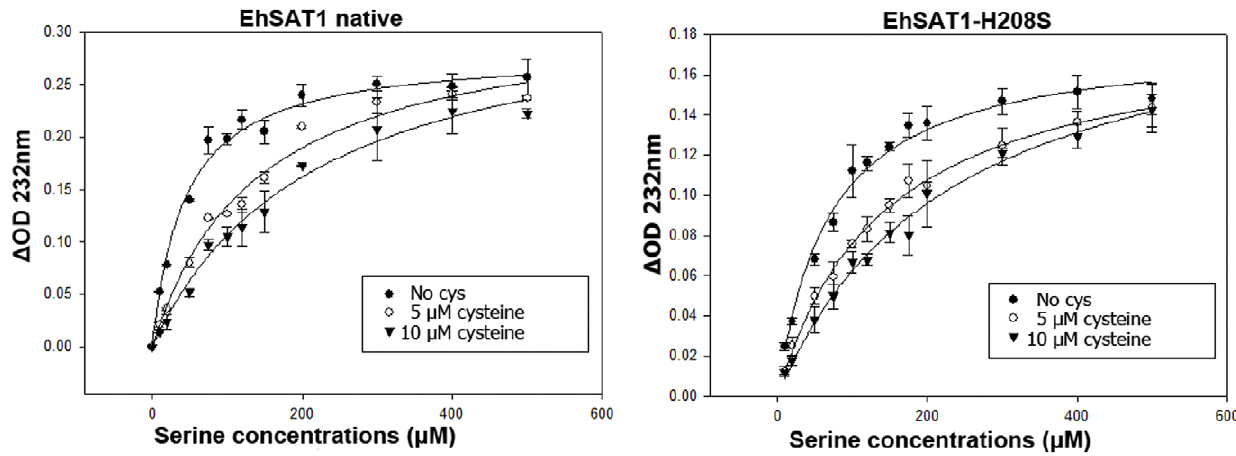
Figure 5. Kinetic study of EhSAT1. Michaelis Menten representation of velocity values plotted against the serine concentrations for EhSAT1 native and mutant (H208S). Kinetic studies were done in 50 mM Tris buffer pH 8.0 keeping acetyl CoA concentration constant at 0.1 mM and varying concentration of serine from 10 m M to 500 m M. The inhibition studies were done in presence of 5 m M and 10 m M of cysteine. K m was calculated by the Michaelis Menten equation using Sigma Plot software. Standard deviations are calculated from the three independent experiments for each substrate concentration values. The competitive inhibition is intact in the both native as well as mutant but the overall activity of the mutant has decreased by about 50%.